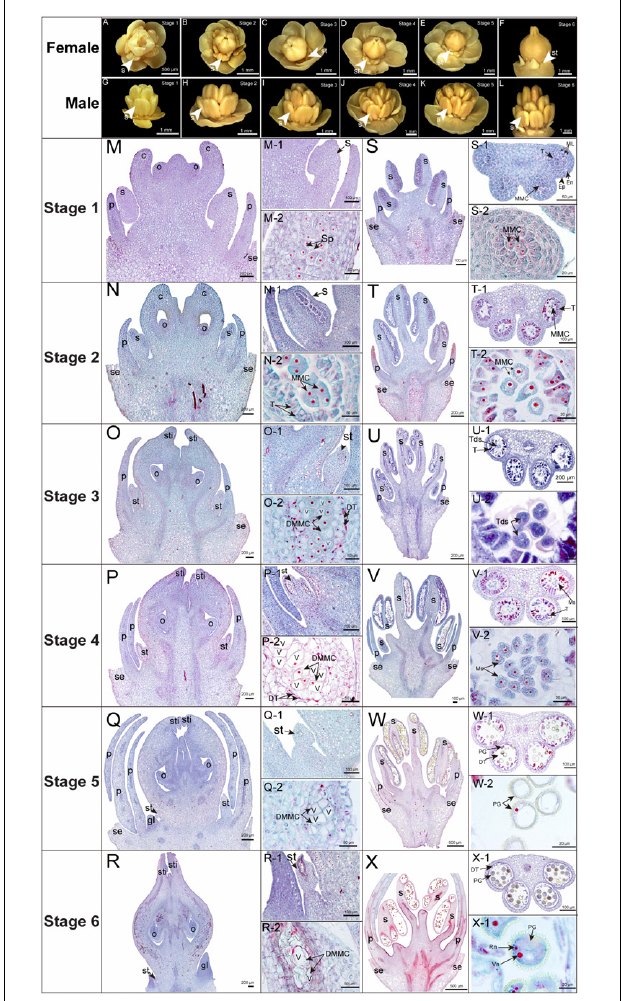
FIGURE 1 | Morphological and cytological observations of male and female flowers. (A–L) Morphological observation. (M–X) Cytological